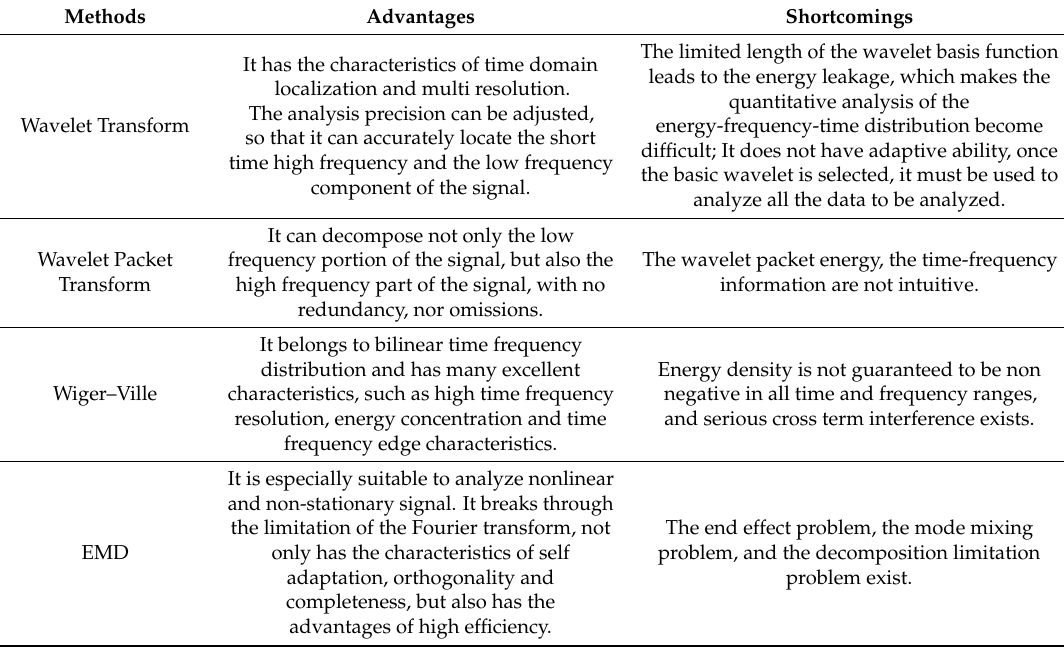
Table 1. Comparison of different time-frequency domain